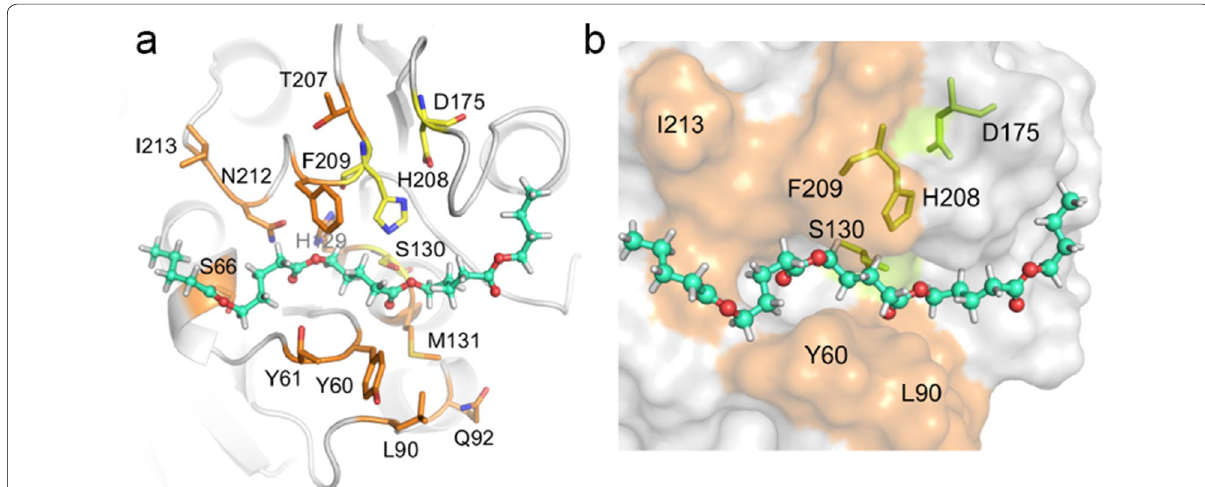
Fig. 2 The structure of a T. fusca cutinase monomer. a Surface and b cartoon of T. fusca cutinase bound with the oligo-polyester C 24 H 48 O 8 substrate. Green balls-and-sticks: the substrate molecule C 24 H 48 O 8 . Yellow sticks: the catalytic residues. Orange sticks: the bulky residues selected to be